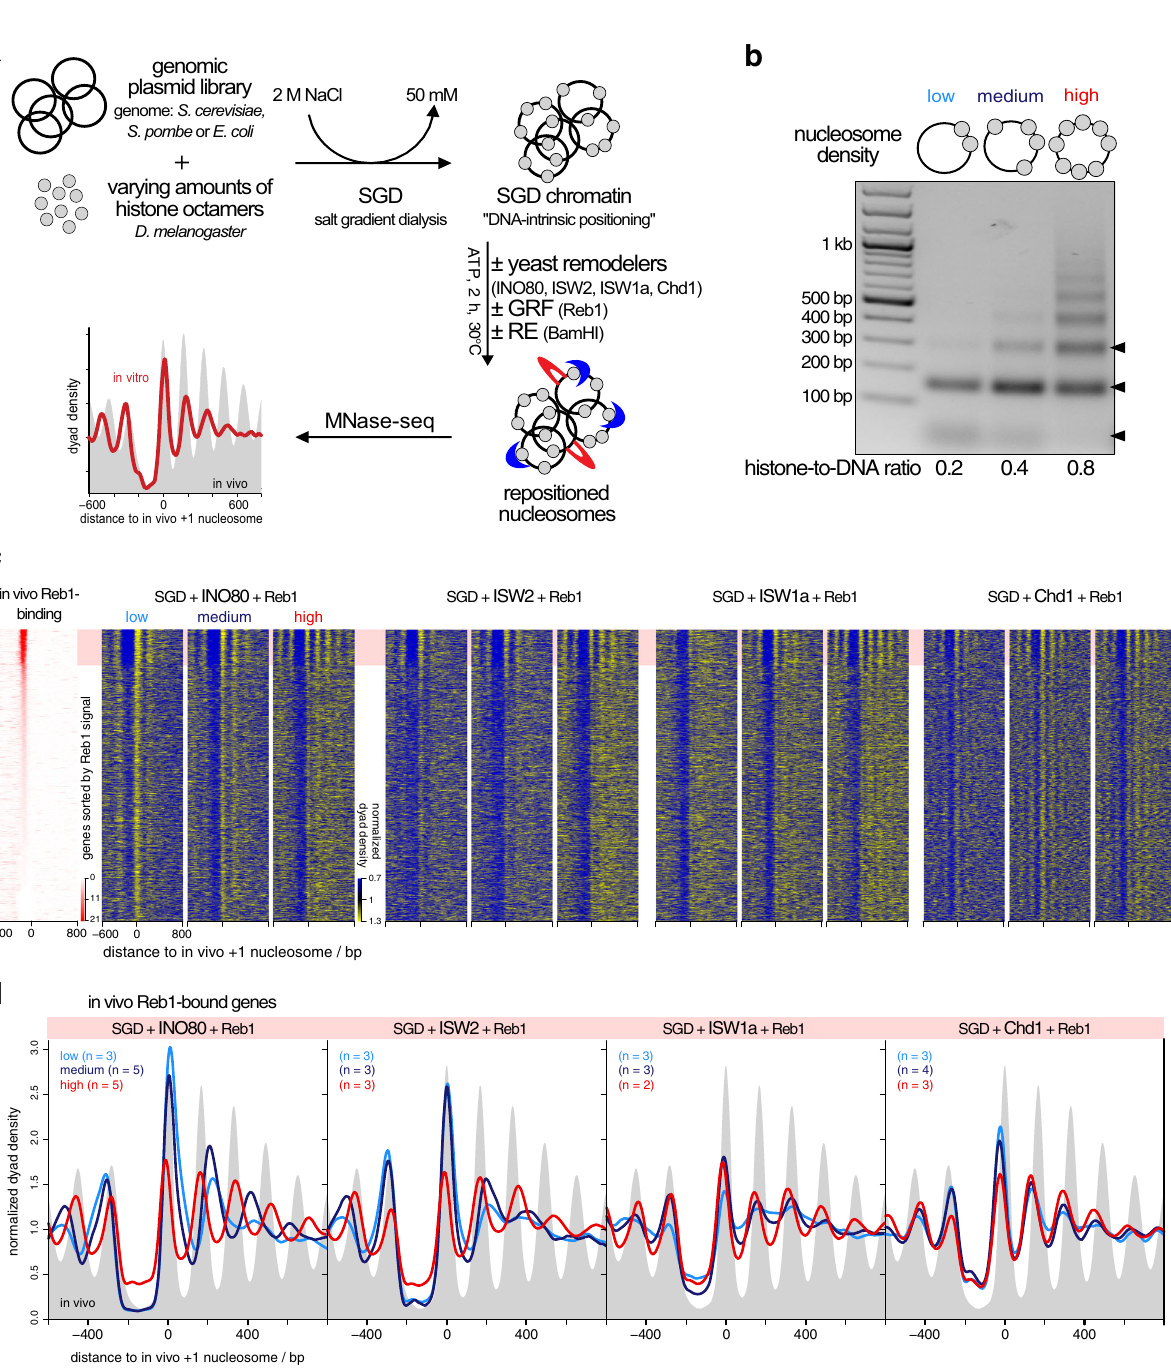
Fig. 1 Reb1-guided nucleosome positioning in vitro by individual remodelers at varying nucleosome density. a Overview of genome-wide in vitro reconstitution system. (GRF general regulatory factor, RE restriction enzyme). b Comparison of SGD (salt gradient dialysis) chromatin reconstituted at indicated histone-to-DNA mass ratios. DNA fragments after Micrococcal Nuclease-digest under the same conditions were resolved by agarose gel electrophoresis. Arrow heads on right point to subnucleosomal, mono- and dinucleosomal fragments (bottom to top). MNase digest and agarose gel electrophoresis was performed for every SGD chromatin sample. Results were similar to those shown here. c Heat maps of MNase-seq data for SGD chromatin of the indicated nucleosome density (low, medium, high) and after incubation with indicated remodelers and Reb1. Chd1 refers to the Chd1/ FACT complex. Heat maps are aligned at in vivo + 1 nucleosome positions and sorted according to decreasing (top to bottom) anti-Reb1 SLIM-ChIP score 49 (Reb1 signal) as measure for in vivo Reb1 binding and shown in leftmost heat map. Horizontal red shading highlights genes with strong in vivo Reb1 binding at promoters. Merged data of replicates are shown, individual replicates in Supplementary Fig. 1b, c. d Composite plots for data as in c averaged over the indicated number of replicates ( n ) and only for genes highlighted in red in c . Gray background shows in vivo MNase-seq data generated in this